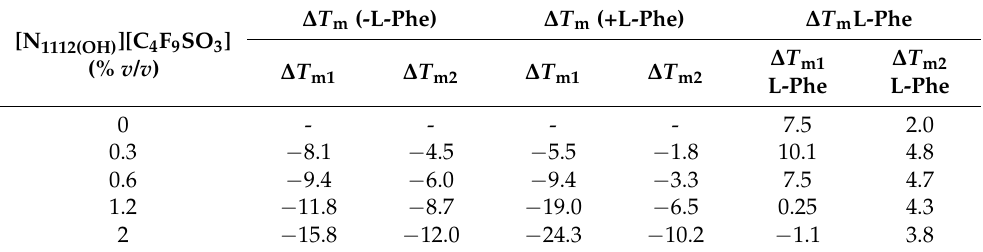
Table 2. Variation of hPAH melting temperatures ( T m ) measured by nanoDSF. ∆ T m – T m variation in the presence of [N 1112(OH) ][C 4 F 9 SO 3 ] compared to those in its absence; ∆ T m L-Phe– T m variation in the presence versus absence of 1 mM